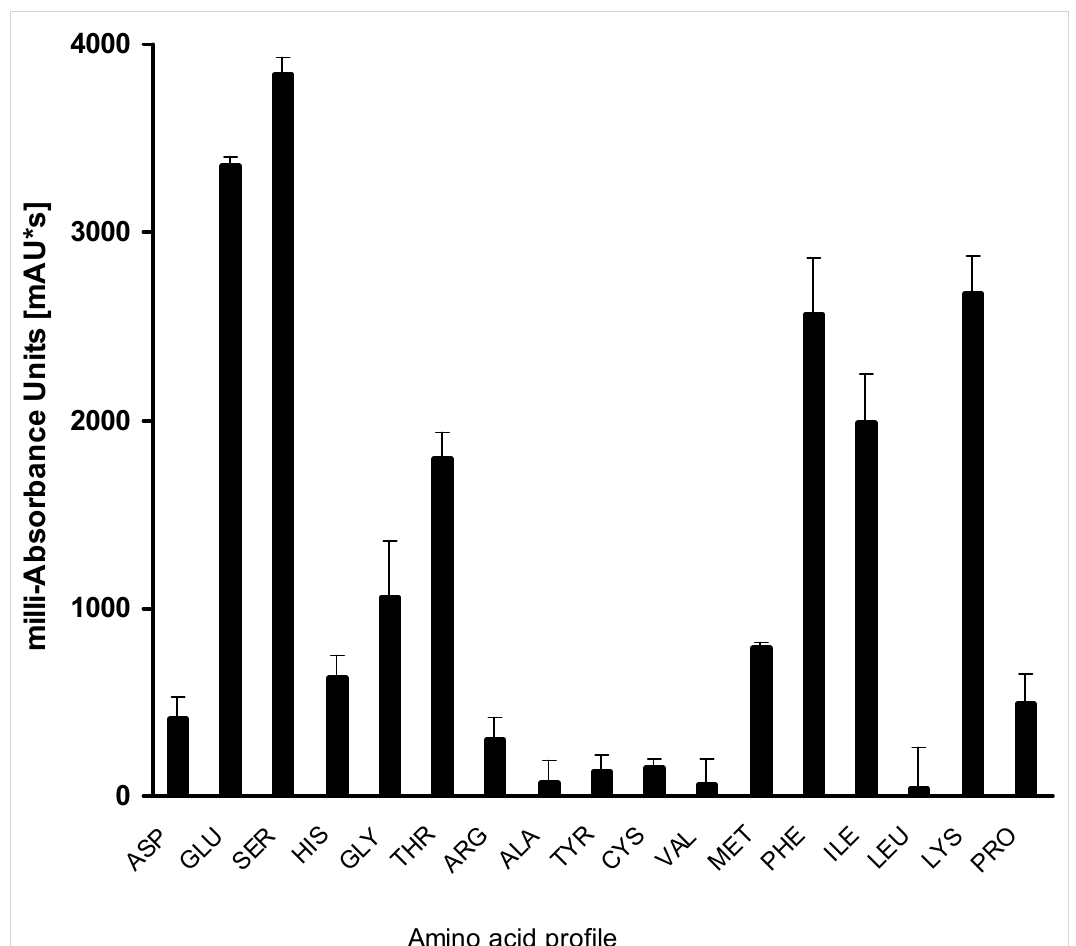
Figure 4. Amino acid profile of Bacillus sp. UPM-AAG1 hydrolysate. Error bars represent mean ± standard deviation (n = 2).